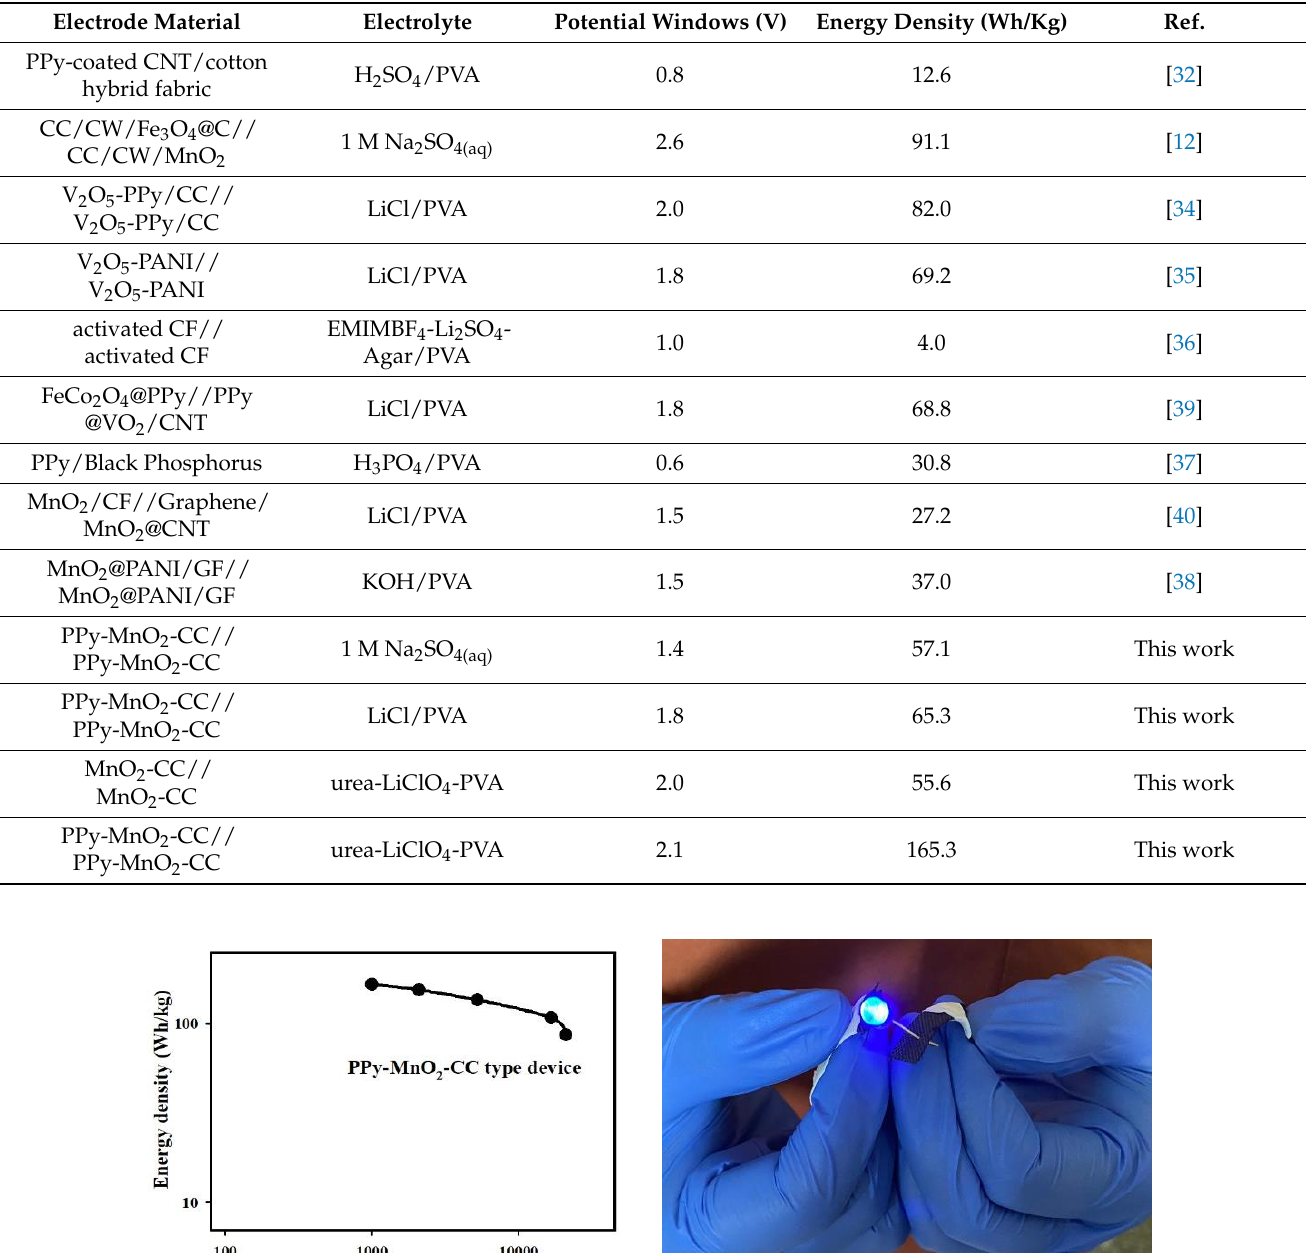
Table 1. Comparison of flexible supercapacitors.